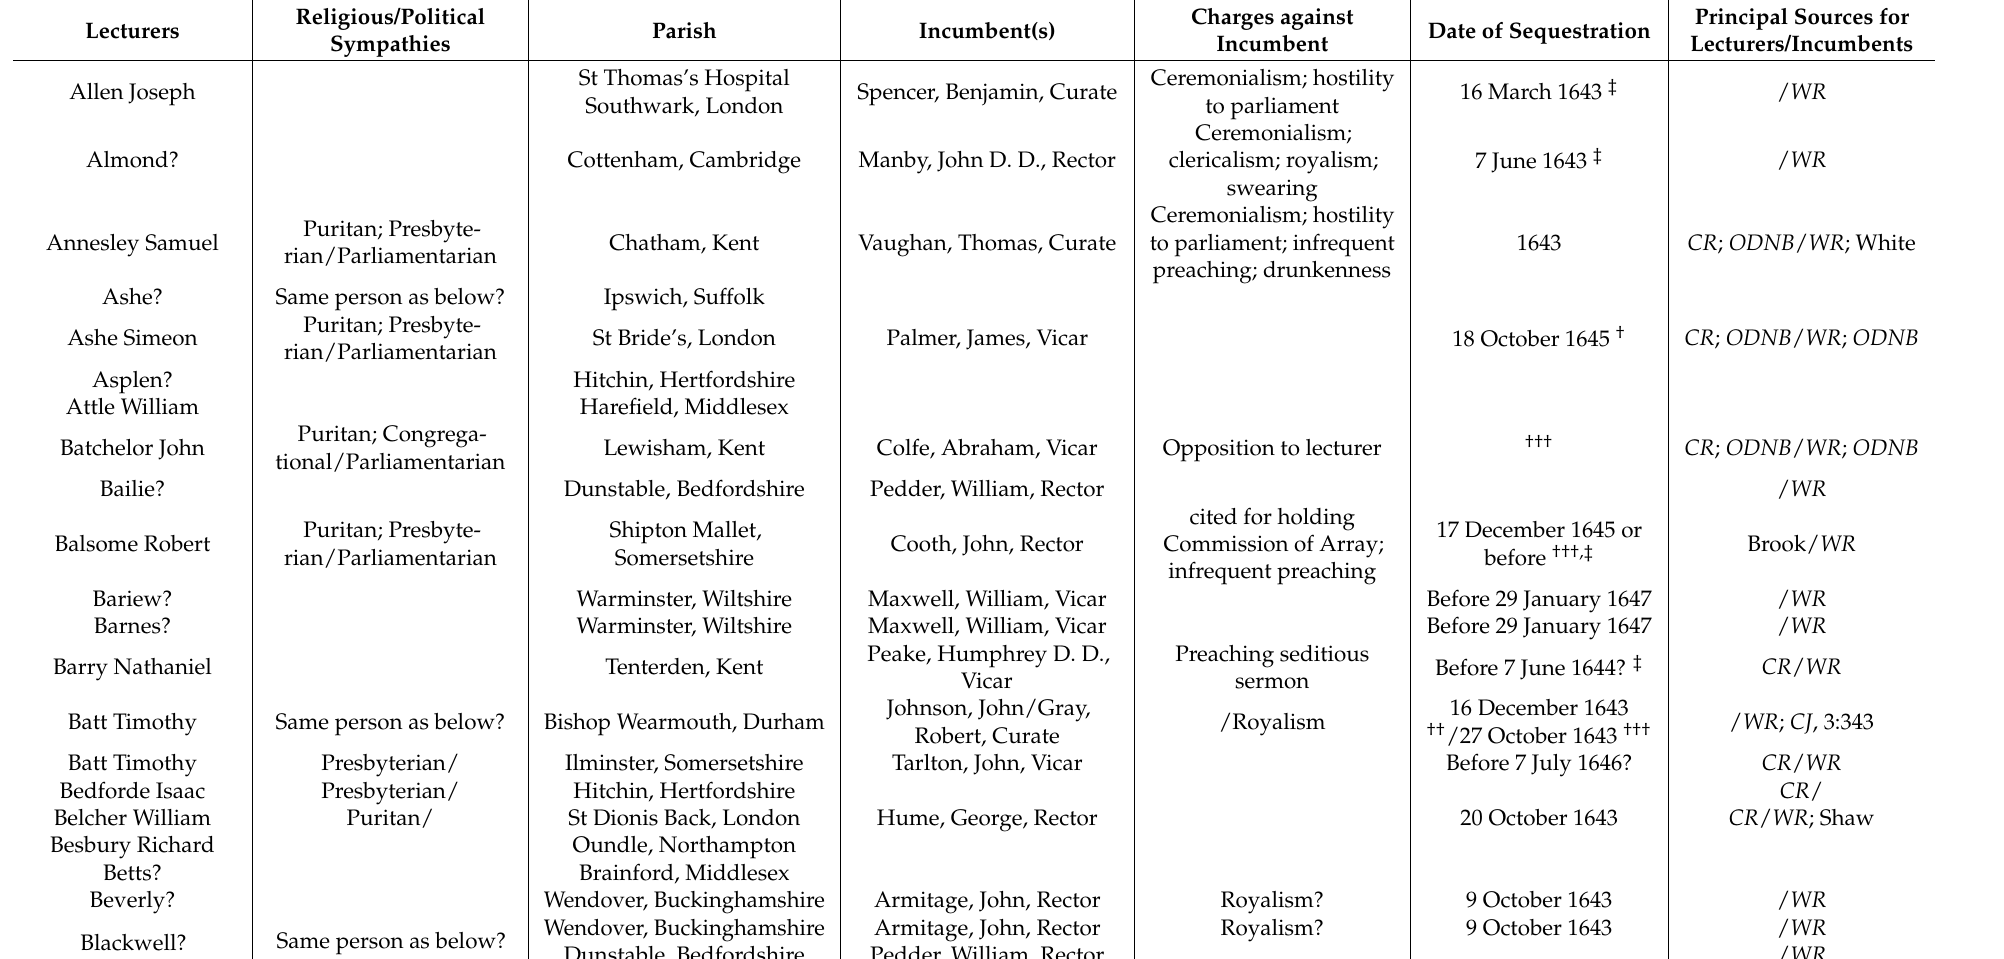
Table A1. Puritan Lecturers and Anglican